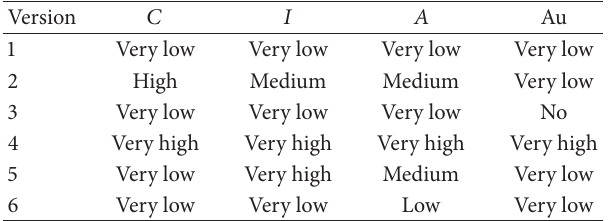
Table 10: The qualitative interpretation of QoP evaluation of the analysed versions of TLS